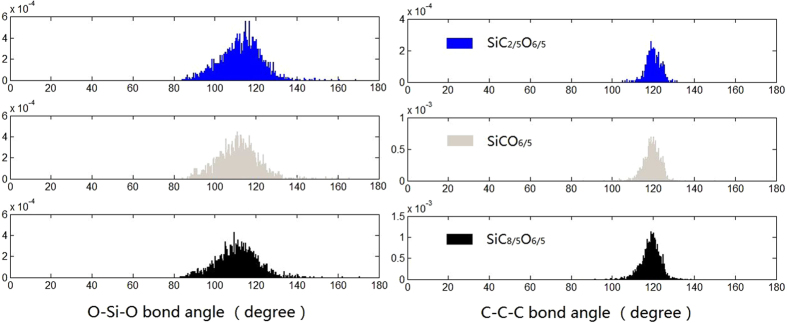
Angular distributions of the amorphous SiCxO6/5 structures.